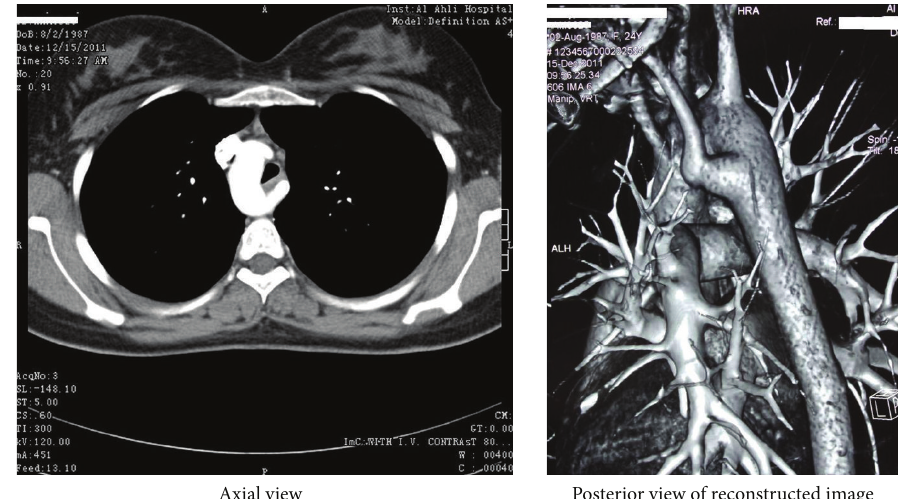
Figure 3: A collated picture of chest CT scan with an image of axial view and a reconstructed image with posterior facing showing a right- sided aortic arch, an aberrant origin of left Subclavian artery (Kommerell’s diverticulum) behind the oesophagus which was obscured due to